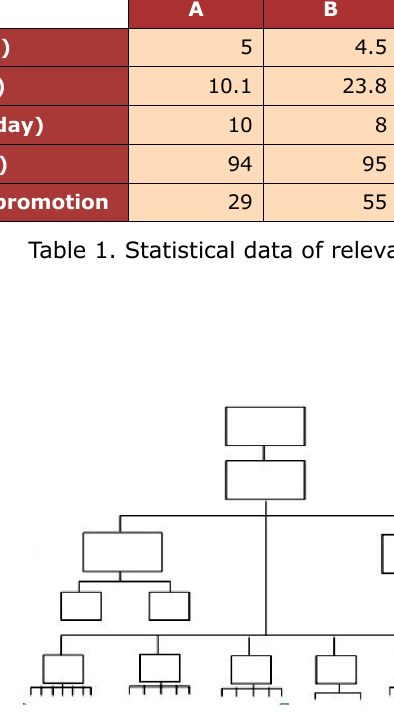
Figure 3. Organization chart of A